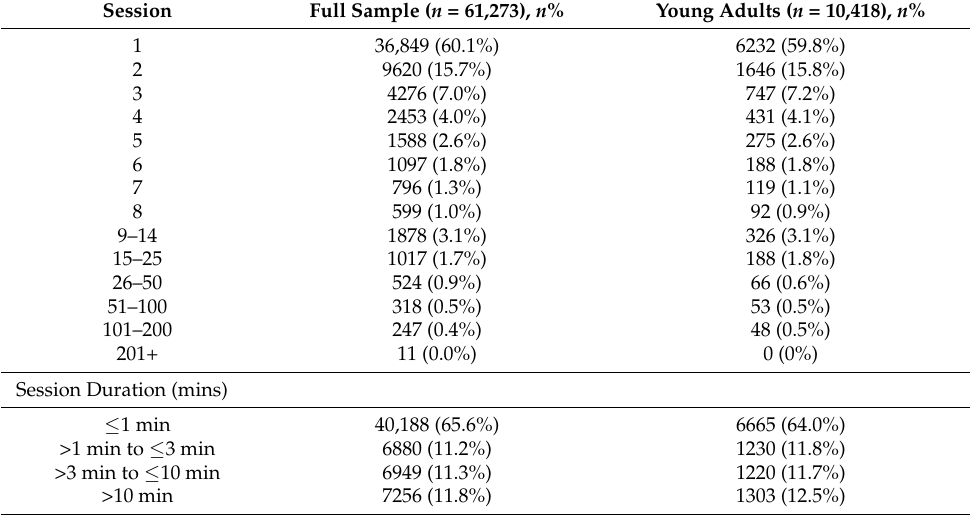
Table 4. Frequency and duration of visits.